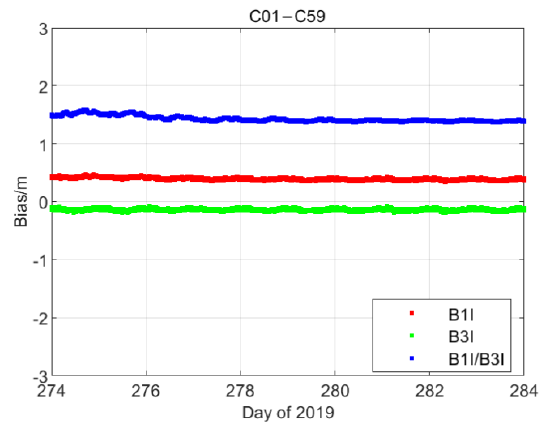
Figure 1. The pseudorange bias extraction result from the C01 satellite, as obtained by the type B receiver.